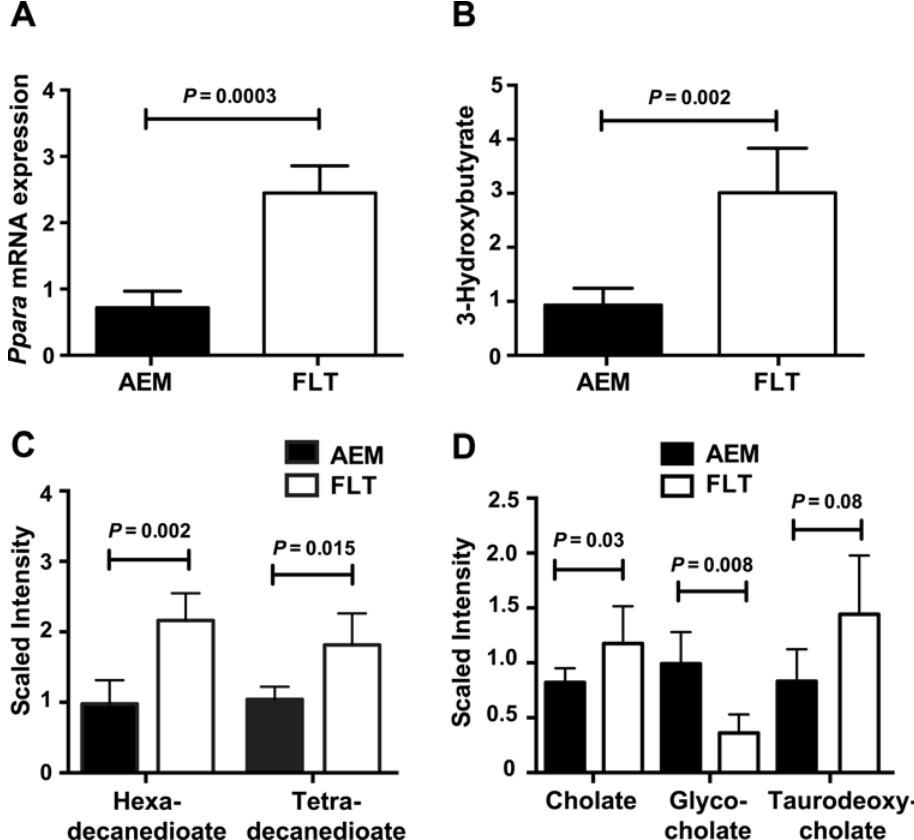
Fig 5. Products of PPAR α -mediated thioesterase activity are upregulated in spaceflight mice. A ) Hepatic PPAR α mRNA expression was quantified using qRT-PCR and normalized to 18S rRNA levels for both FLT mice and AEM controls. An unpaired t-test with Welch ’ s correction was used for comparison. PPAR α targets include acyl-coA thioesterases, which act in different cellular compartments to mediate lipid